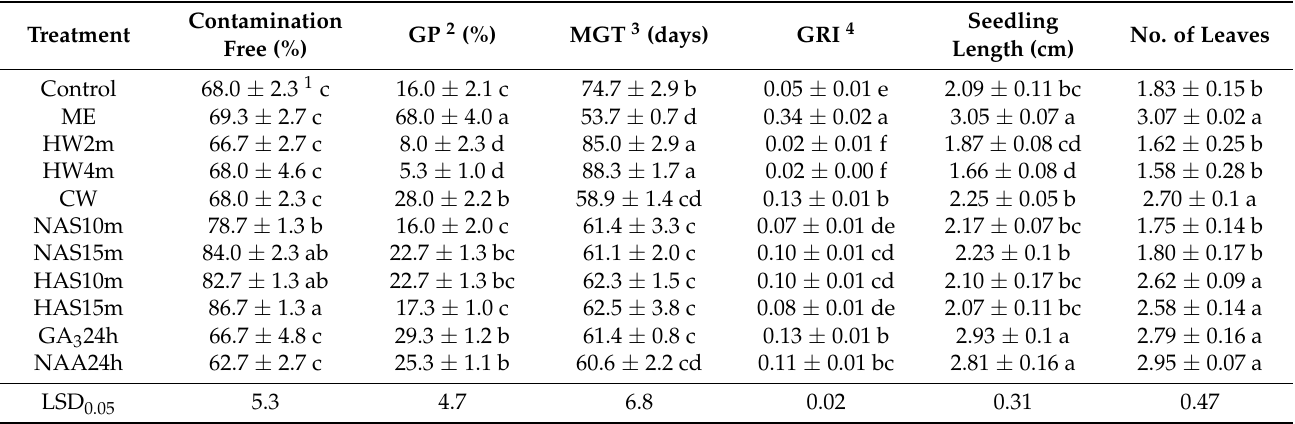
Figure 3. In vitro germination steps of untreated black cardamom seed: ( a , b ) radicle emerges (at 75th day of culture): op—operculum, pr—primary root, sbr—shoot-borne root; ( c ) coleoptile emerges and is pierced by the primary leaf (at 85th day of culture): cp—coleoptile, hc—hypocotyl, pl—primary leaf; ( d , e ) the first leaf grows, expands, and is supplemented by additional leaves (at 85th and 110th day of culture, respectively): lb—leaf blade, ls—leaf sheath. Scale bars = 0.5 cm. 3.3. Effect of Seed Treatments on the Germination and Seedling Growth of Black Cardamom under In Vitro Conditions different between seed treatments after 10 days of culture (Table 2). Table 2. Different seed treatment effects on seed germination and seedling growth of black cardamom cultured in vitro.